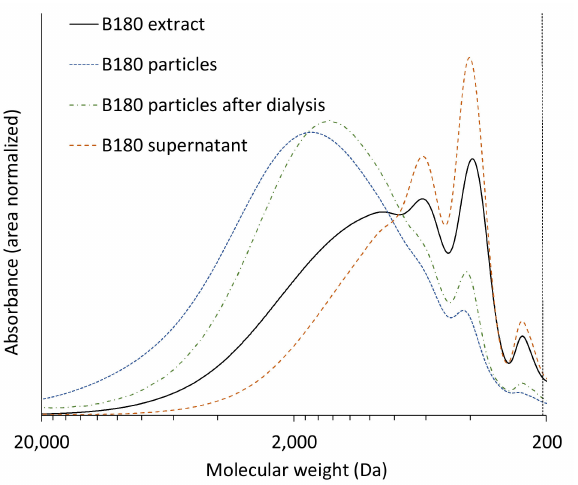
Figure 5. M w in the different process fractions for wheat straw, spruce, and beech.